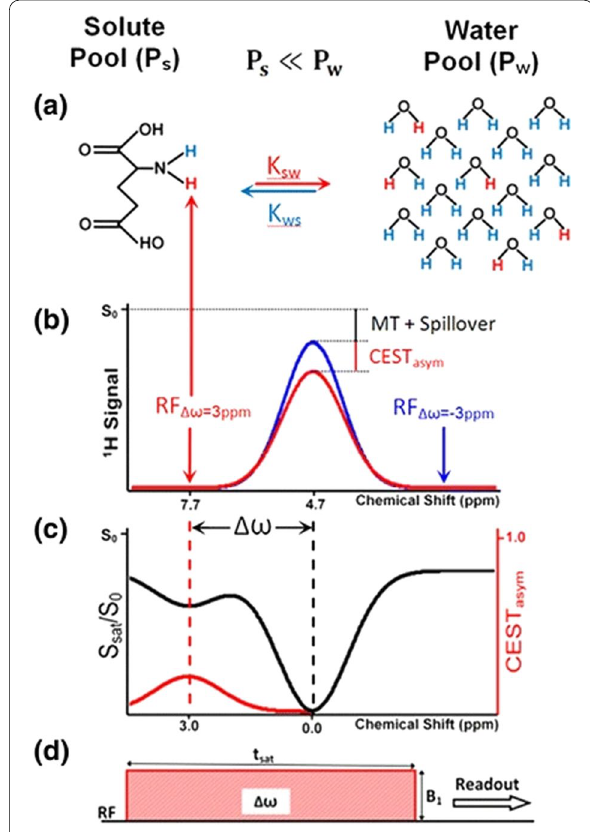
Fig. 2 Transfer of hydrogen protons and the resulting difference in water signal as an indicator of glutamate concentration using the Glu CEST method [92]. Figure reproduced from Kogan et al. [92], Curr Radiol Rep 1 pp 102–114. Reprinted by permission from